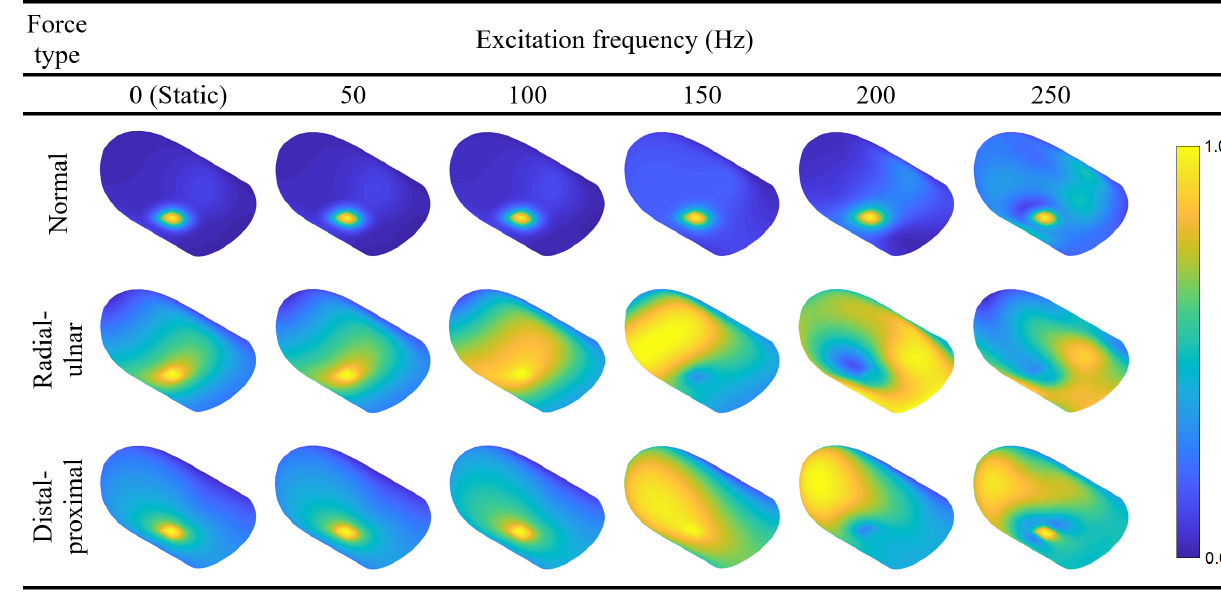
Figure 7. Forced vibration mode shapes of the fingertip excited by harmonic forces applied in the region of the fingerprint centroid. The loads are applied in the normal, radial–ulnar, and distal–proximal directions. The excitation frequencies range from 0 (static condition) to 250Hz with an increment of